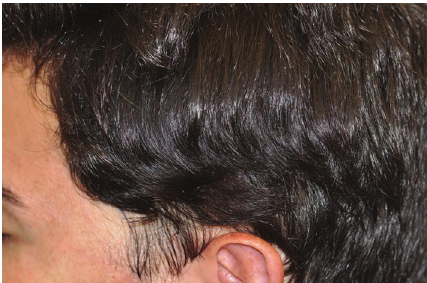
Figure 7: Left side after hair transplant, over six